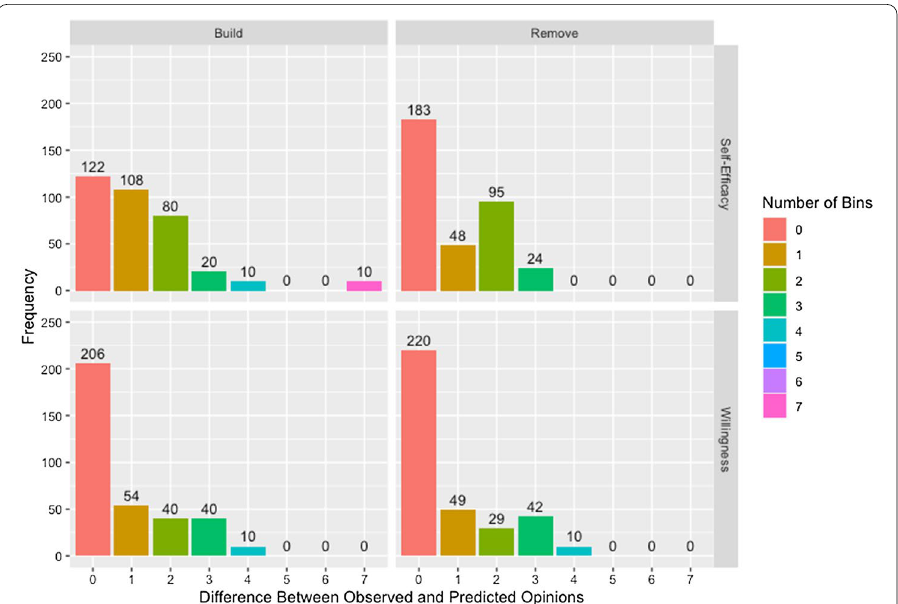
Fig. 17 Difference between observed and predicted opinions by adjacency matrix and measure. Difference between observed and predicted opinions measured in number of bins by adjacency matrix construction method and measure across all networks and runs of the